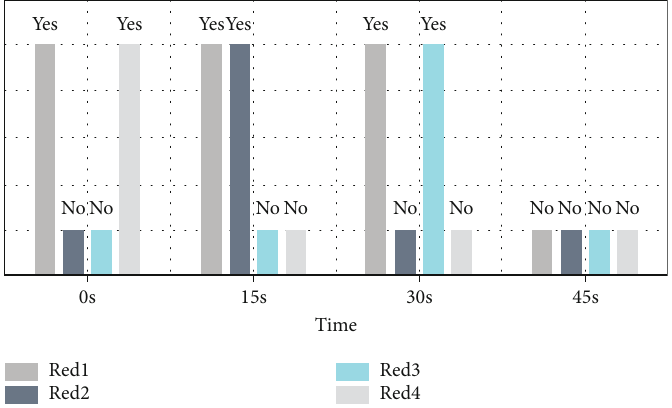
Figure 10: Attack intent of the